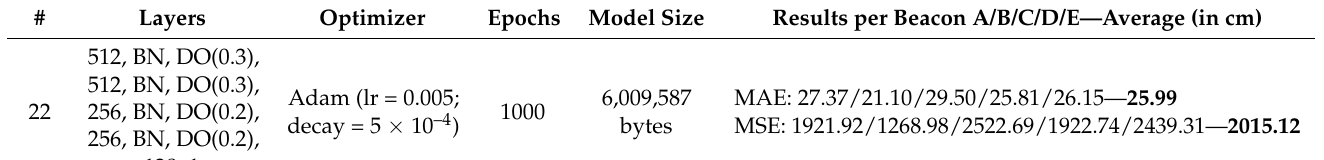
Table 10. Experiment No. 22 parameters and results.